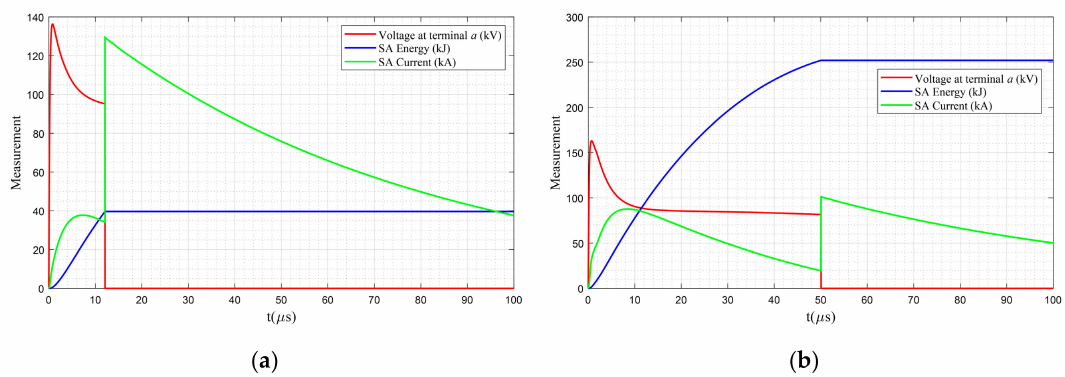
Figure 15. Failure of 36 kV surge arrester ( a ) for SA-36a under 150 kV lightning impulse and ( b ) for SA-36b under 200 kV lightning impulse.